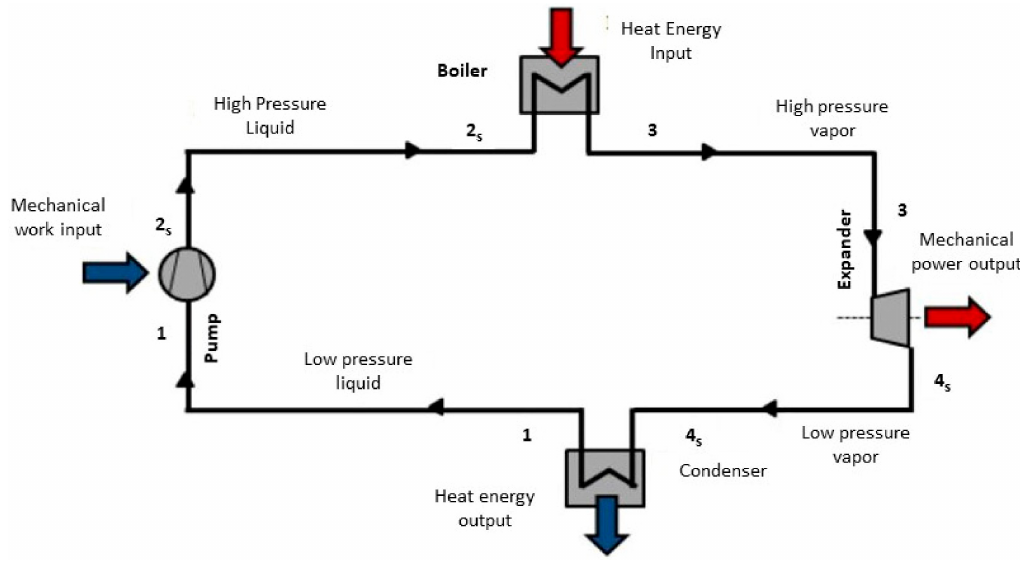
Figure 8. Basic Organic Rankine Cycle (ORC) System Layout.